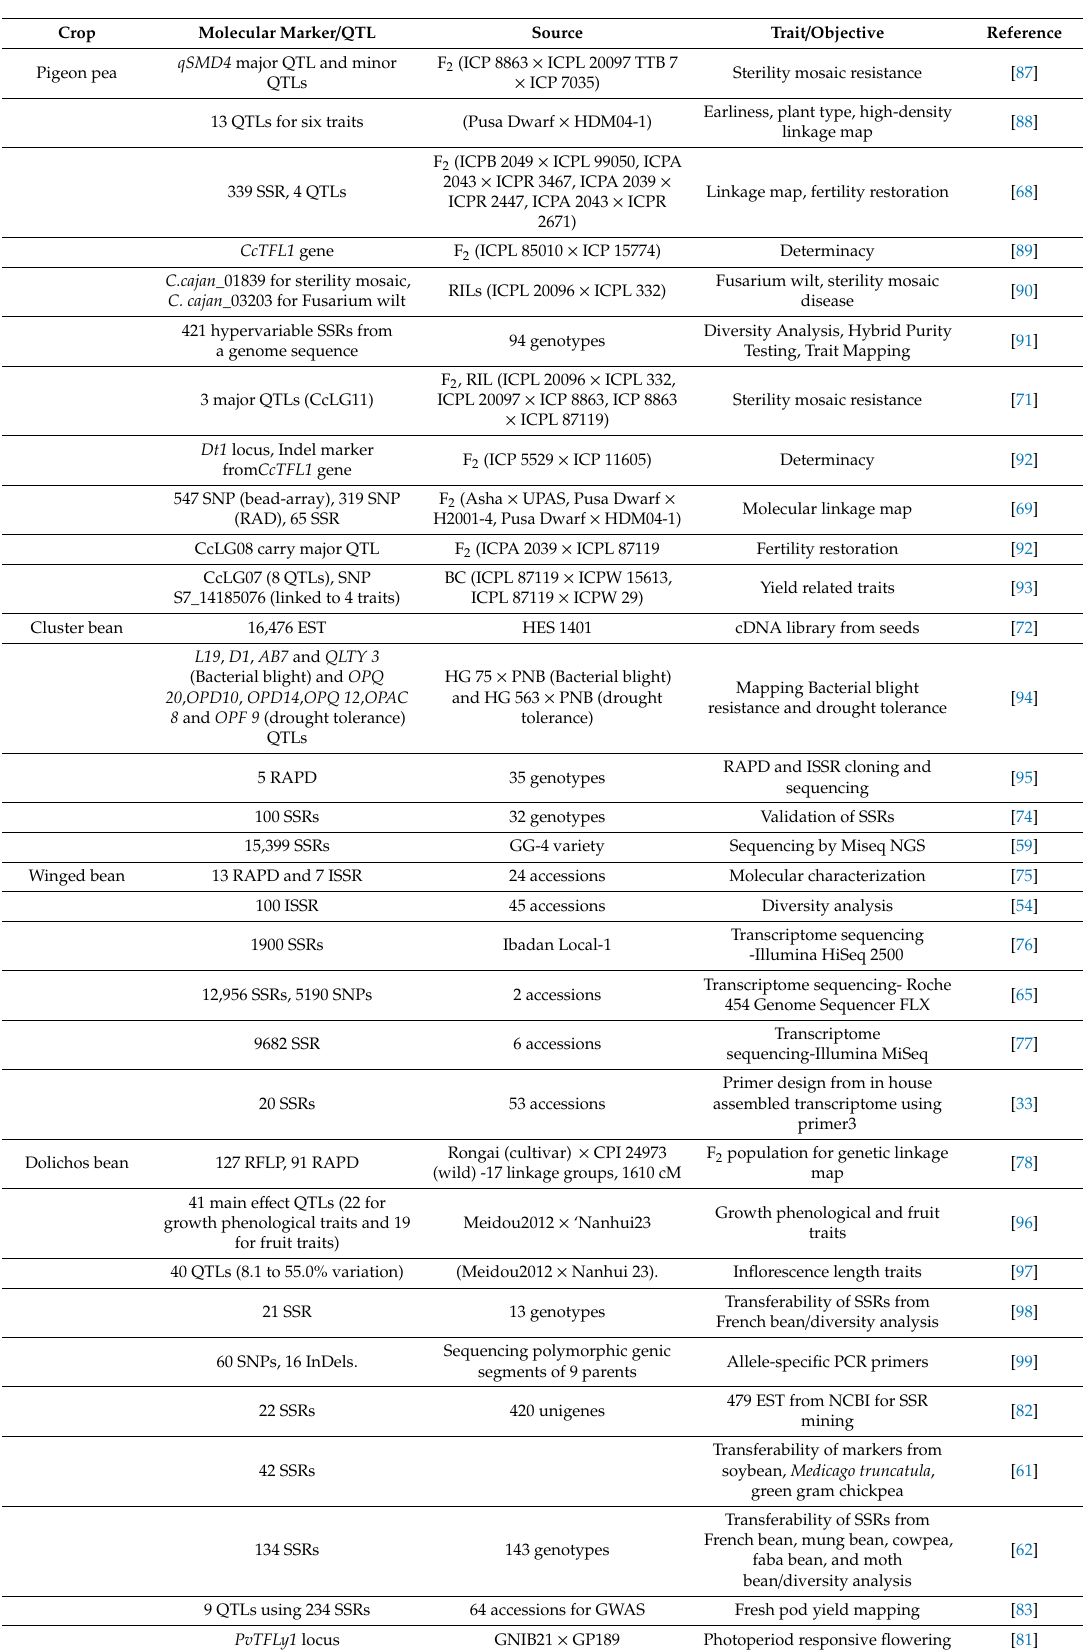
Table 1. Molecular markers and mapped quantitative trait loci (QTLs) in vegetable legumes. Crop Pigeon